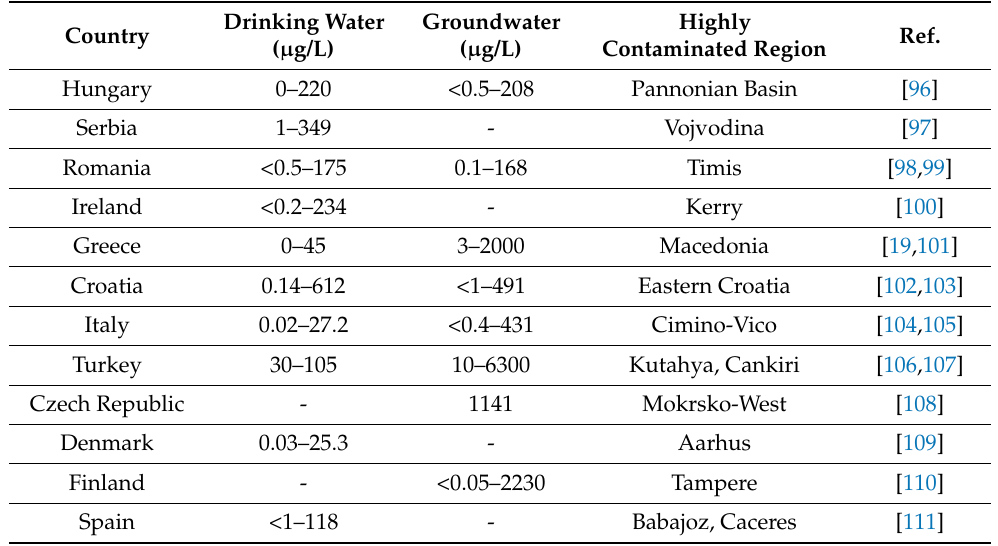
Table 3. European regions and concentration of arsenic in water (selected data from recent literature).